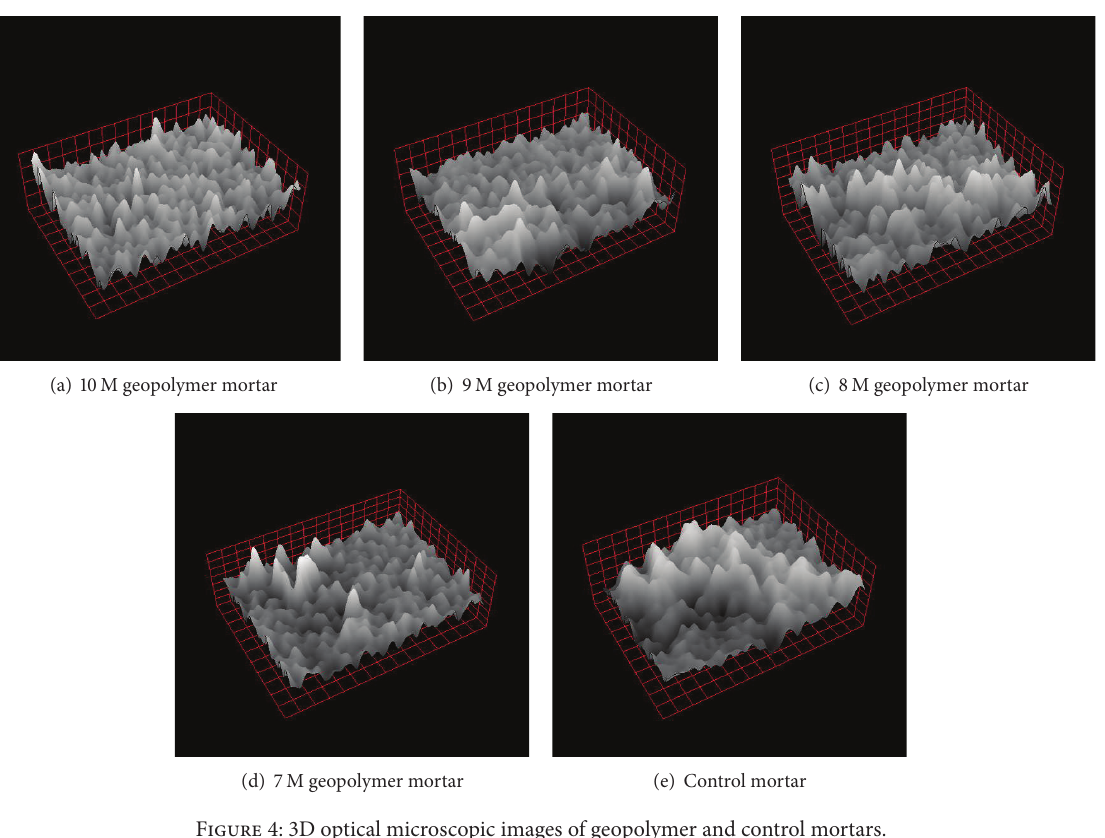
Figure 4: 3D optical microscopic images of geopolymer and control mortars.